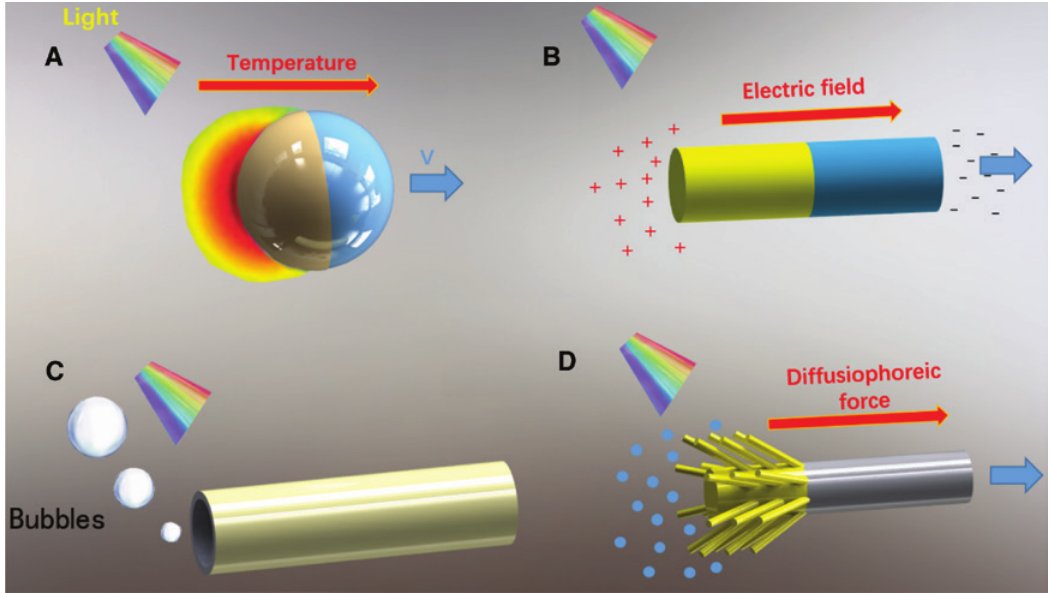
Figure 2: Different structures with different kinds of actuation mechanism. (A) Microspheres with photothermal-effect propulsion, wherein motors move along with the temperature gradient. (B) Nanorod with self-electrophoretic propulsion, wherein motors move along with the electric field around them. (C) Nanotubular with bubble-induced propulsion, wherein motors move away from the direction where the bubbles generate. (D) Asymmetric brunches with osmotic propulsion, wherein motors move under the diffusiophoretic